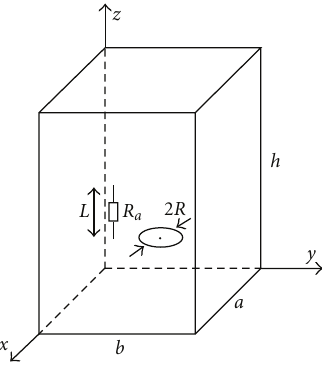
Figure 1: Electrical and magnetic dipoles in a resonator.